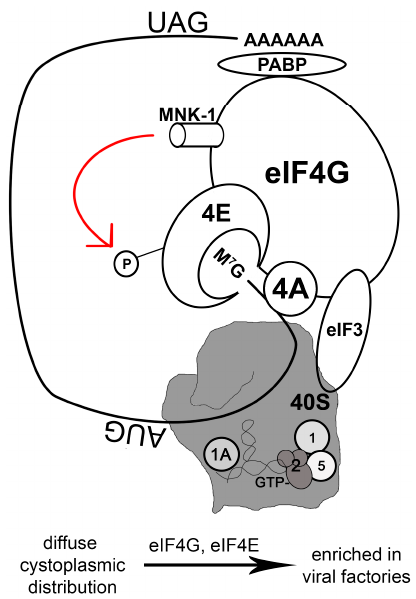
Figure 1. Regulation of the translation initiation complex by Mnk1 and the impact of vaccinia virus infection. For cellular or viral mRNAs containing the 7-Methylguanosine-cap structure (shown as M 7 G) on the 5’ end, recruiting host ribosomes to the mRNA is a critical event. The eukaryotic translation initiation factor 4F (eIF4F) (not shown) plays an important role in this process. eIF4F is a tripartite complex including a cap-binding subunit (eIF4E) (shown as 4E), a small RNA helicase (eIF4A) (shown as 4A), and a large scaffold protein (eIF4G) that directly interacts with the poly(A) binding protein (PABP) and a 40S-ribosome-associated protein (eIF3). The mRNA circulates by interacting with PABP at the 3’-end (depicted by a stop codon of UAG and the poly(A) tail of the mRNA) and associating with eIF4G at the 5’-end. The 43S preinitiation complex that consists of the small 40S ribosomal subunit (portrayed in a gray block at the back) and initiation factors, including eIF1 (shown as 1), eIF1A (shown as 1A), a ternary complex eIF2( α , β , γ ) ‚ GTP ‚ met-tRNA imet (shown as 2, GTP, and a hairpin structure, respectively), and eIF5 (shown as 5), assembles with eIF4F complex, via eIF3, to form the 48S complex. One of eIF4E kinases, Mnk1, binds to eIF4G and phosphorylates eIF4E (the red arrow represents this phosphorylation event, and the 4E connected to P represents phosphorylated eIF4E). The assembled 48S complex can then scan the mRNA for start codon (AUG). Vaccinia virus (VACV) manipulates this process by enriching the concentration of eIF4G and eIF4E in the viral factories. VACV requires Mnk1 activity for infection.